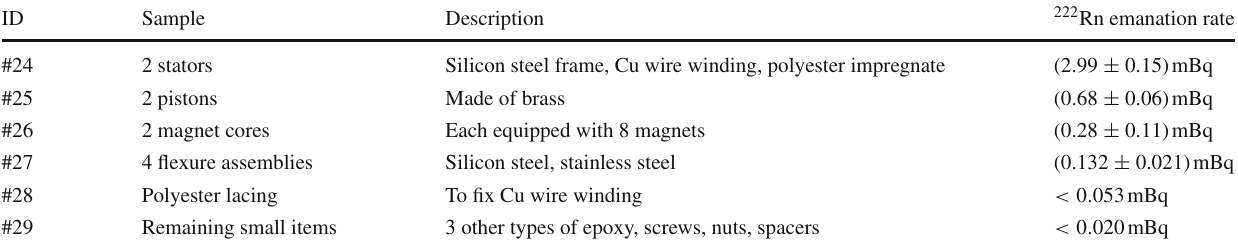
Table 5 222 Rn emanation measurements of all parts of a QDrive recirculation pump prior to assembly